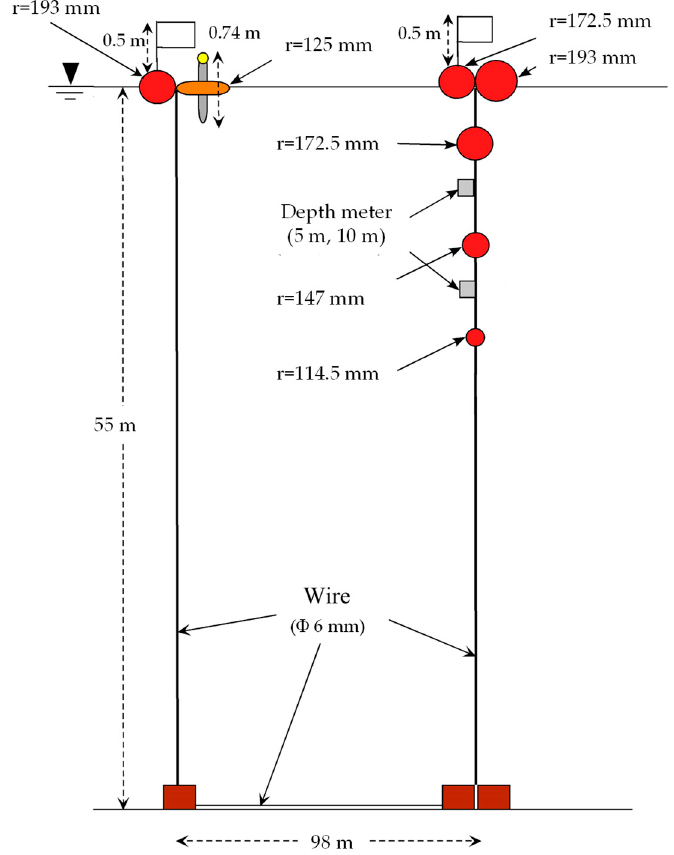
Figure 2. Mooring system in Lake Biwa and the depth metre (water temperature depth metre COMPACT- TD, JFE Advantech, 10-min interval) near the surface (5 and 10 m) settled at the observation point in the lake (Figure 1).